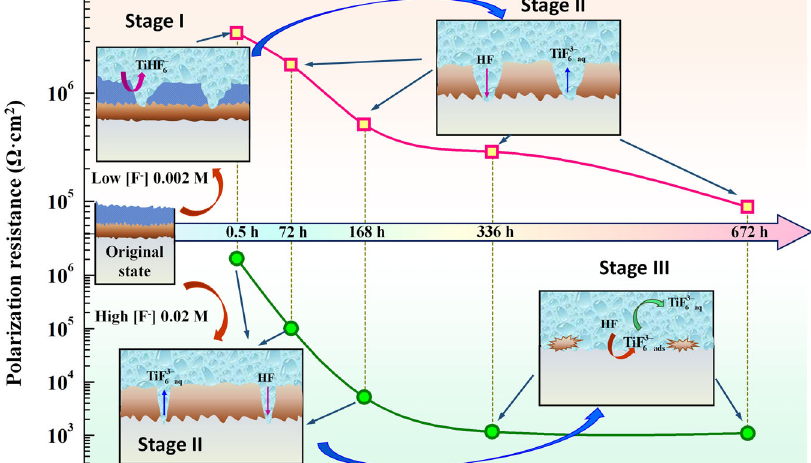
Fig. 11 Changes in polarization resistance and corresponding degradation stages of the thermally oxidized Ti (at 650 °C for 24 h). Surface state variations of the oxidized Ti in the presence of fl